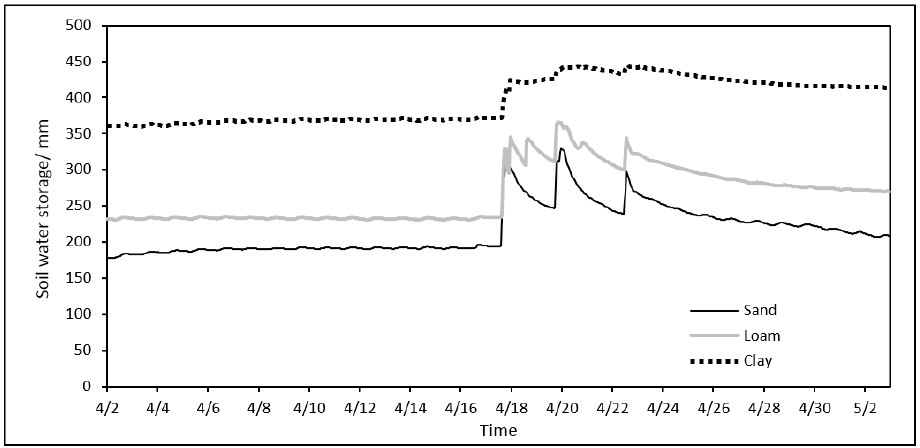
Figure 4. Soil water storage dynamic variation of different type dunes.